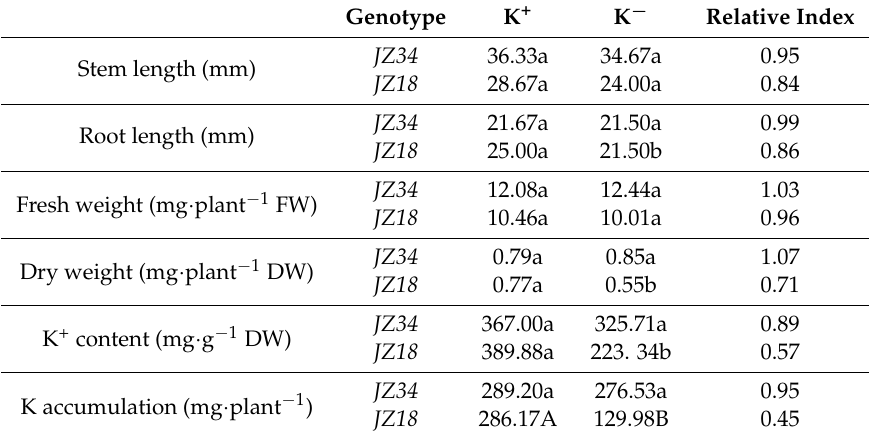
Table 1. Effect of K + level on the biomass, K + concentration and accumulation in two different genotypes at 7 d.